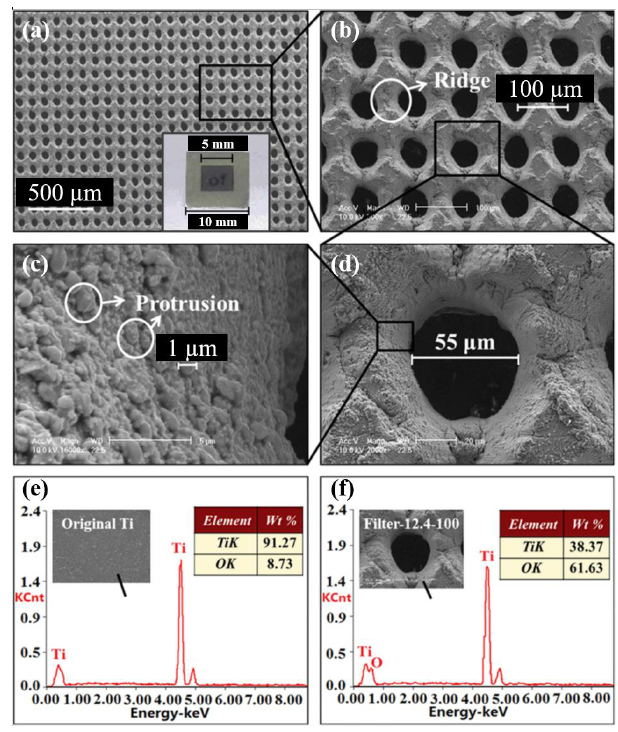
Figure 14. ( a – d ) SEM image of a FS laser-fabricated titanium membrane filter showing the presence of microprotrusions at the periphery of the microholes; ( e , f ) EDX analysis of the pristine and FS laser-treated titanium foil [69].